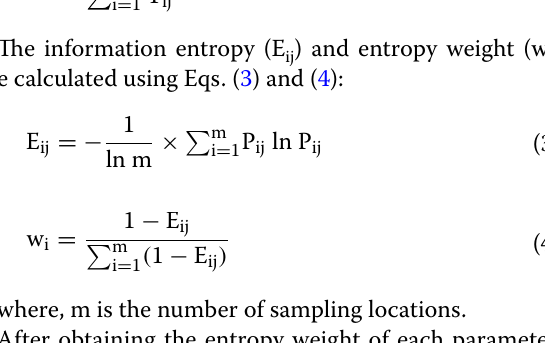
Table 1 Scale and status of surface water quality using